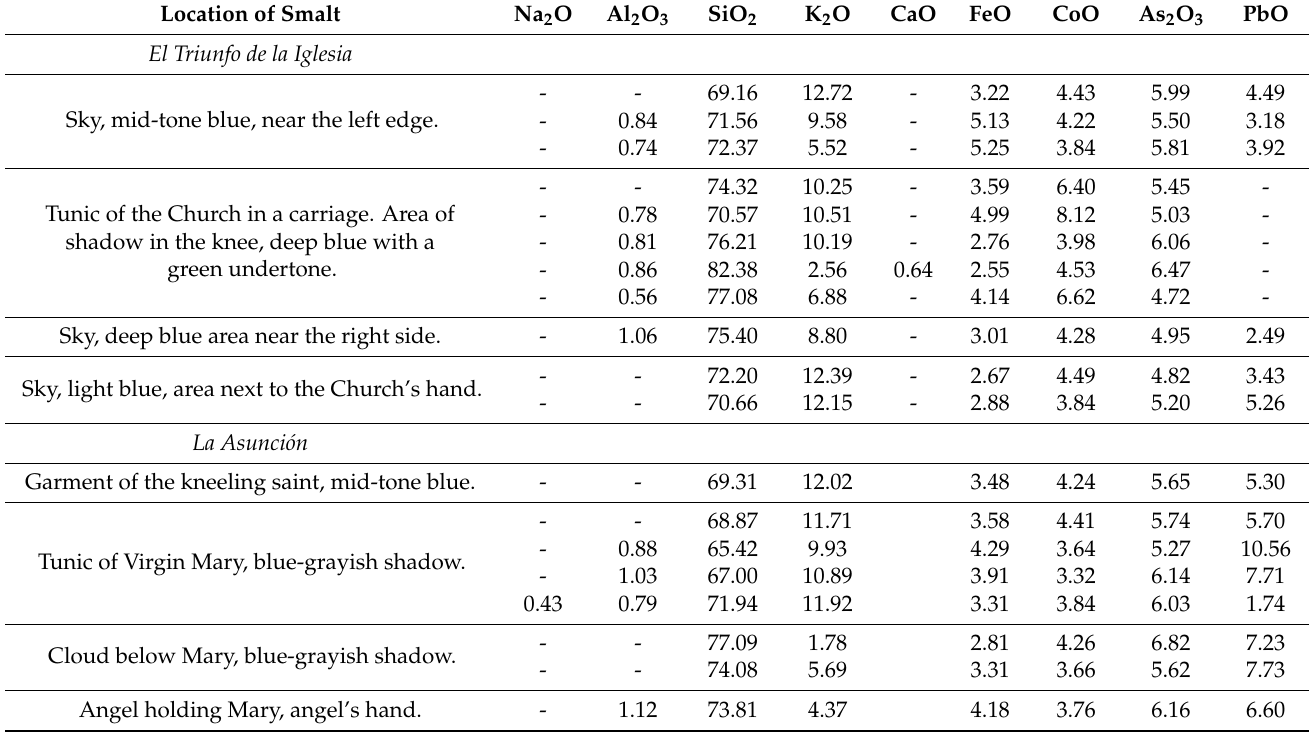
Table 2. Evaluation of potassium and cobalt content in different points of the same particle with quantitative elemental analysis (weight% oxide). Sample Smalt Particle Location K 2 O CoO Particle A (Smalt in good state of La Asunci ó n . Tunic of Virgin Mary, blue-grayish shadow.